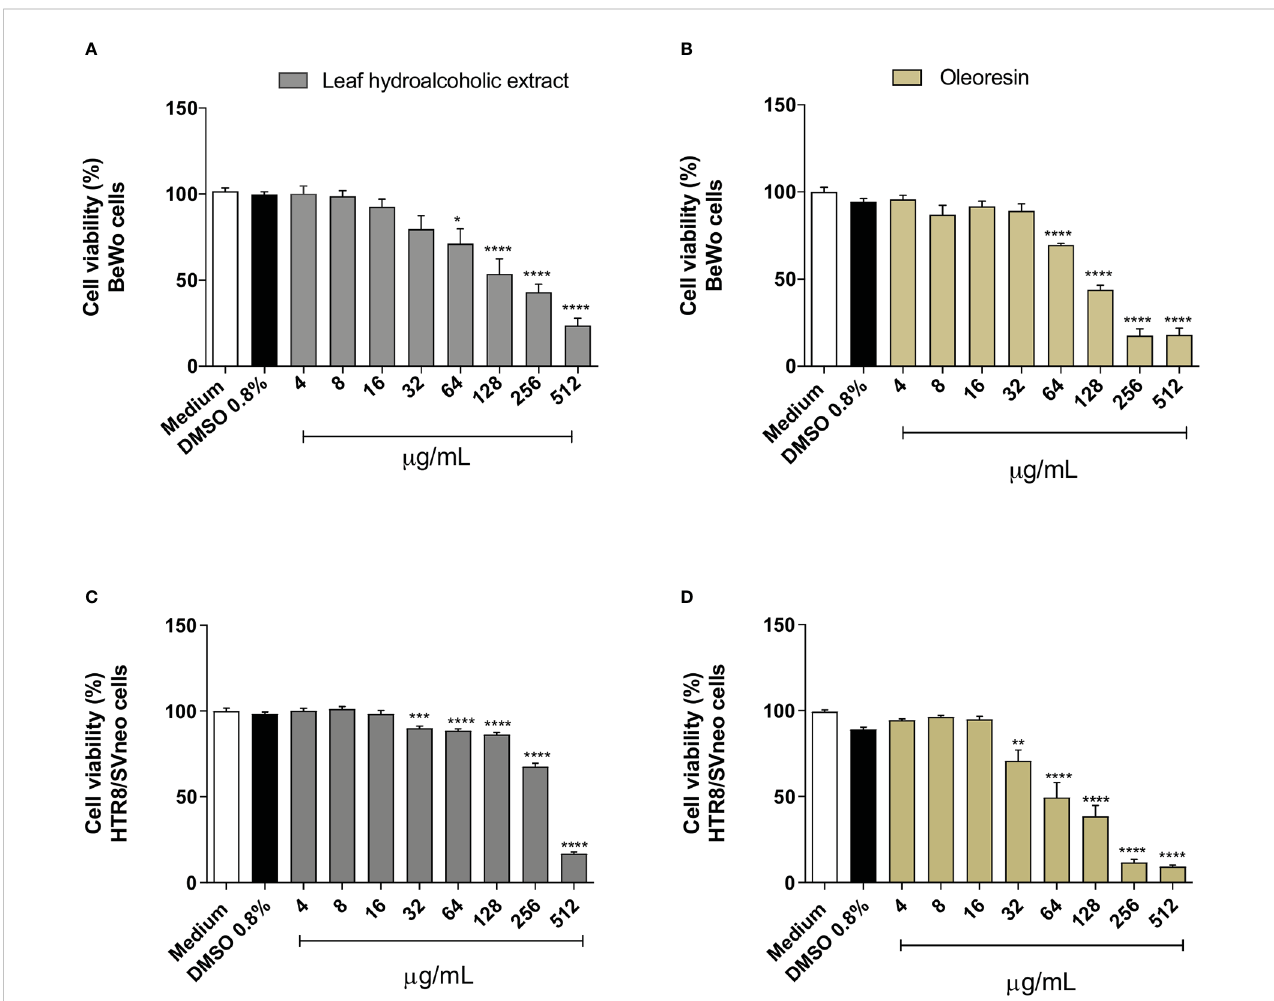
FIGURE 1 Cell viability. BeWo (A, B) and HTR8/SVneo (C, D) cells were treated or not with several concentrations of oleoresin or hydroalcoholic extract from C. multijuga for 24 h, and MTT assay was performed. Cell viability was expressed as percentage (cell viability %), considering the absorbance of cells incubated only with the medium as 100% viability. The results are expressed as means ± standard deviation of three independent experiments performed with eight replicates. Signi fi cant differences detected by One-Way ANOVA with Bonferroni ’ s multiple comparison post-test, or Kruskal-Wallis when appropriate. * P < 0.05, ** P < 0.001, *** P < 0.0001, and **** P < 0.00001 in relation to the